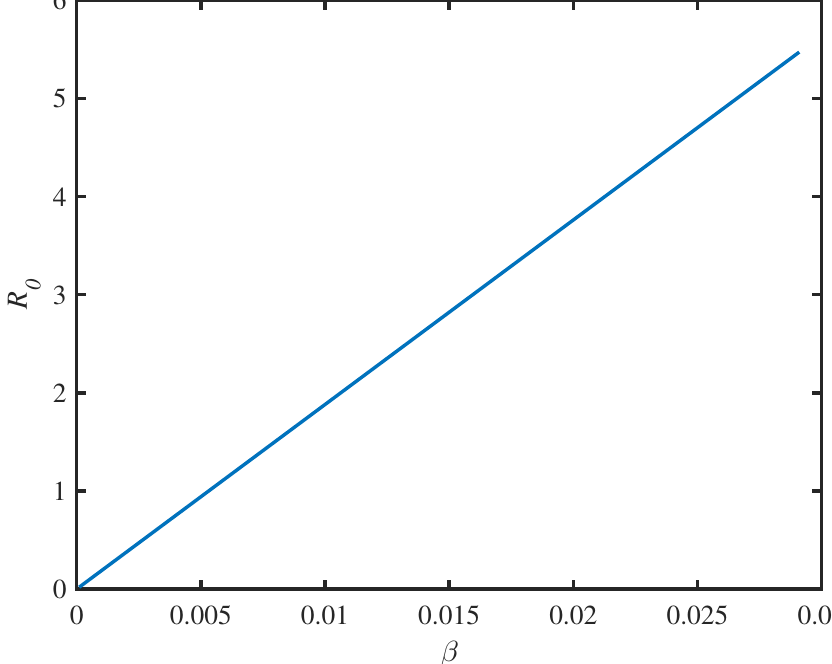
Figure 6. The positive relationship between R 0 and β